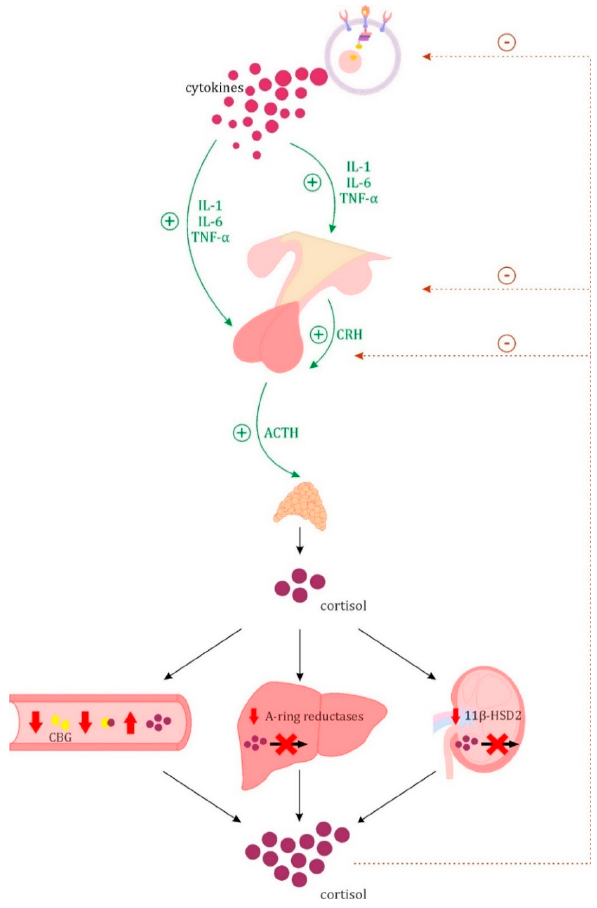
Figure 3. Changes in the action of the hypothalamic–pituitary–adrenal axis (HPA) in sepsis. Inflammatory cytokines (IL-1, IL-6, TNF- α ) increase the secretion of CRH in the hypothalamus and ACTH in the anterior pituitary, which increases the secretion of cortisol by the adrenal glands. In the course of sepsis, there is also impaired cortisol metabolism in the liver by A-ring reductases, and in the kidneys, by 11 β -hydroxysteroid dehydrogenase type 2 (11 β -HSD2). Another mechanism responsible for maintaining high blood cortisol levels may be the decreased level of corticosteroid-binding globulin (CBG). The described disorders lead to hypercortisolemia. High levels of cortisol, through a feedback mechanism, can inhibit the secretion of the HPA axis hormones by the hypothalamus and pituitary gland.